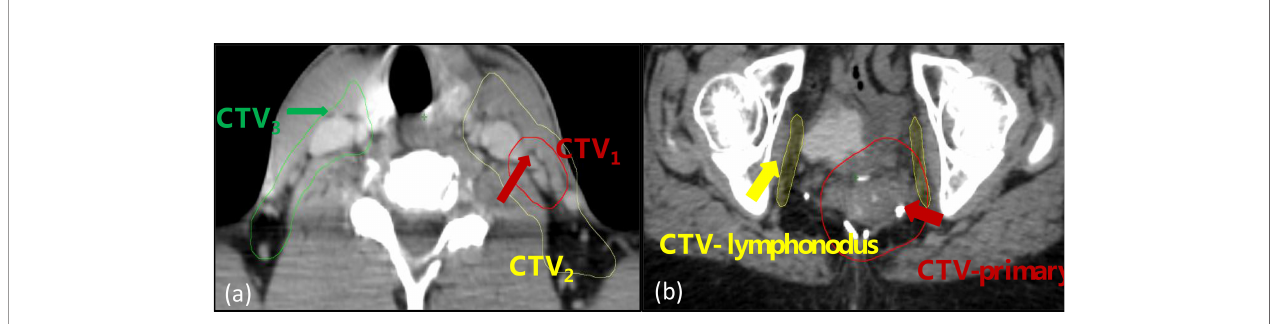
FIGURE 1 | The regions-of-interest (ROIs) included in the analysis: (A) a head and neck case with three volumes designated as CTV 1 , CTV 2 , and CTV 3 ; (B) a pelvic case with two volumes designated as CTV-primary and